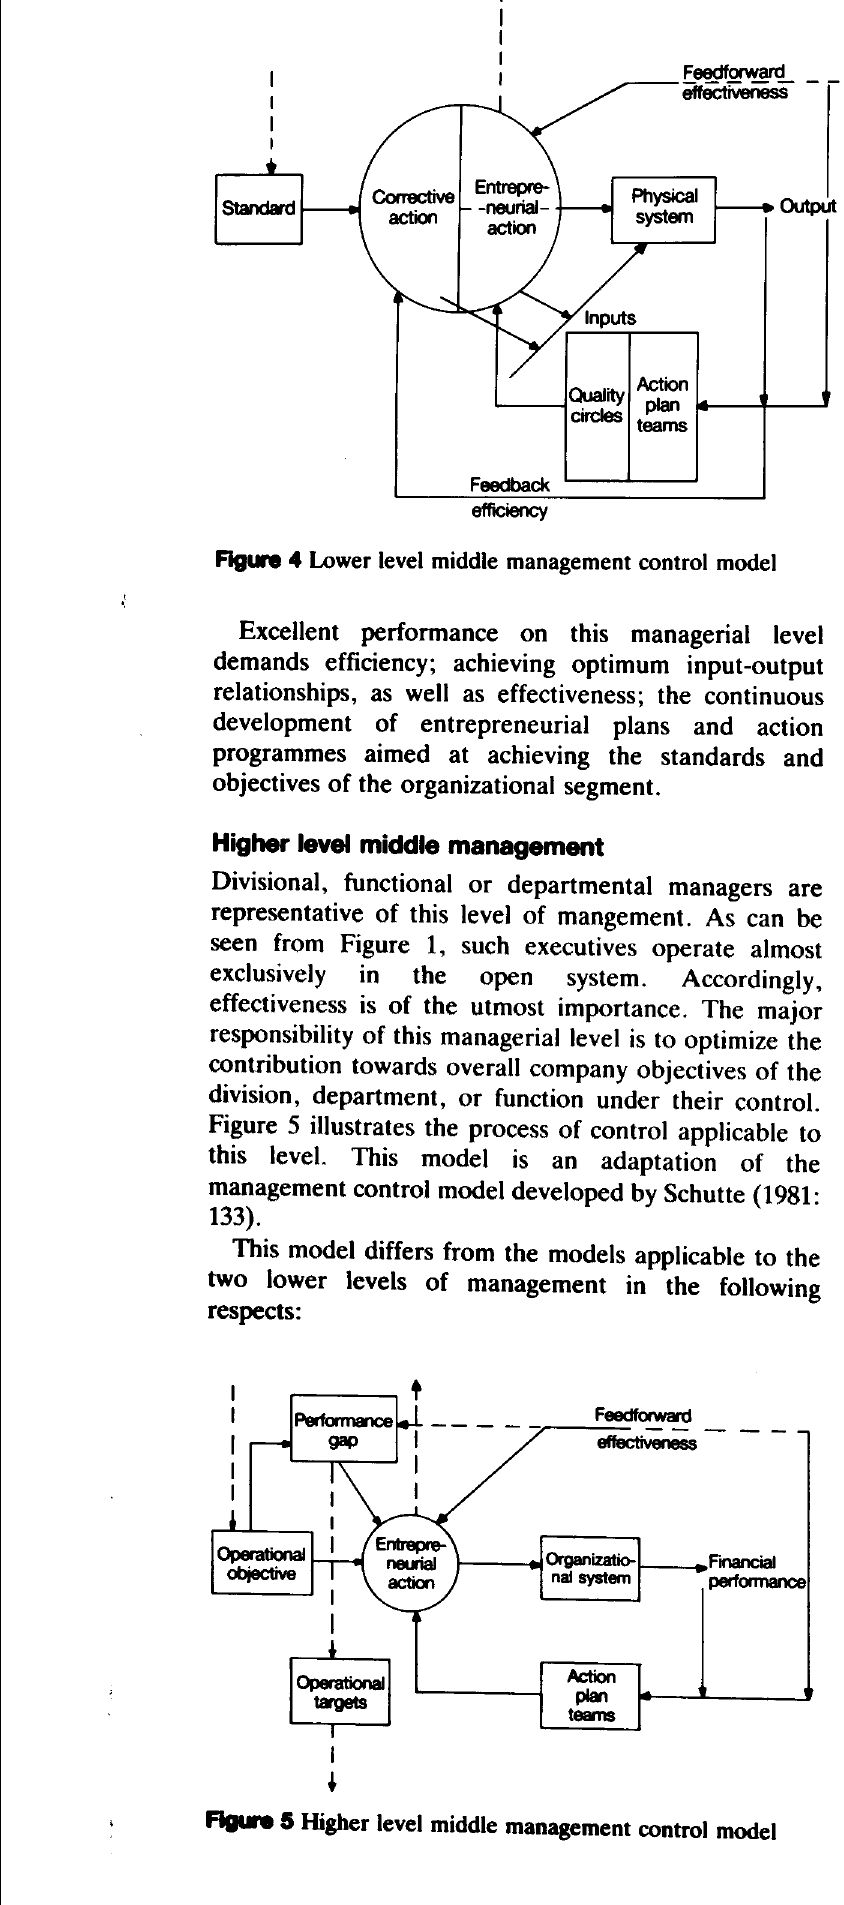
Figure 8 Top level management control